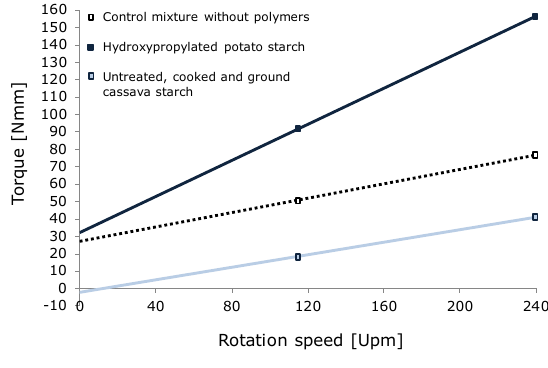
Figure 4. Bingham approximations for the two‐step